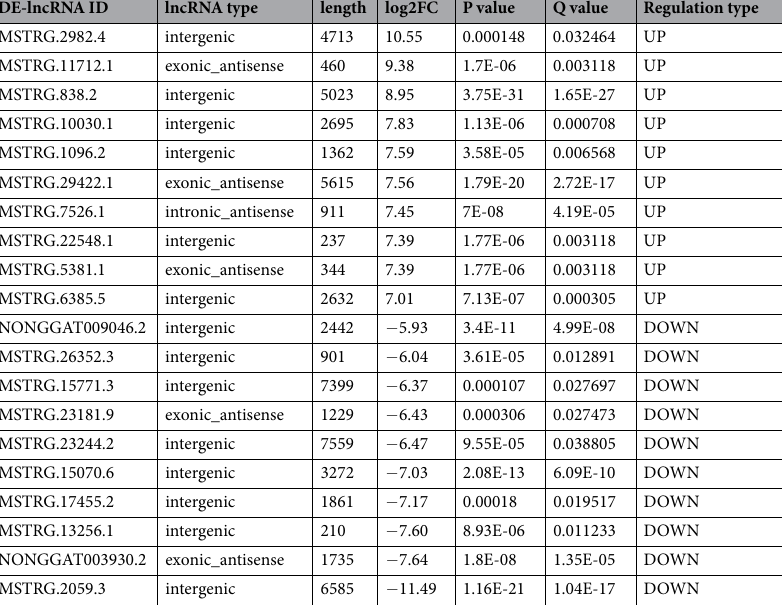
Table 2. List of top differentially expressed lncRNAs in the long-DF hens identified in the UVJ transcriptome (FDR-corrected P-value <